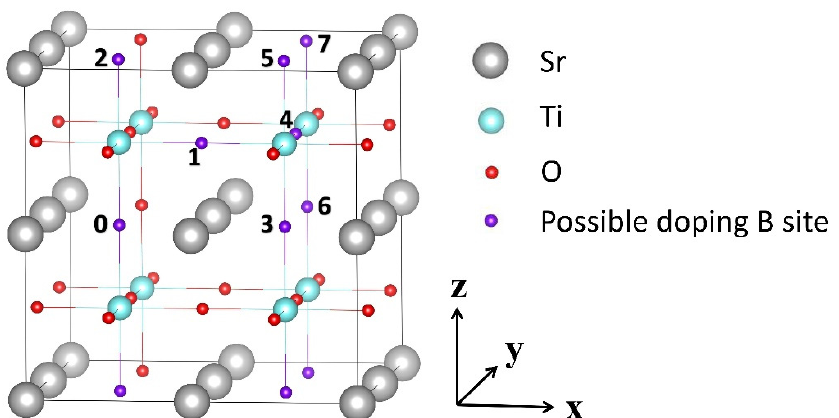
Figure 1. The model of the corresponding di ff erent substitutional B anion structures of SrTiO 3 is provided. We label di ff erent configurations as (0,j), where the position of the first dopant is fixed and labeled 0, while the other alternative doping positions are labeled j. Color codes: gray for Sr, red for O atoms, cyan for Ti, and violet 0–7 for the possible positions of the B dopant. The x, y, and z axes refer to the crystallographic a , b , and c directions, respectively.